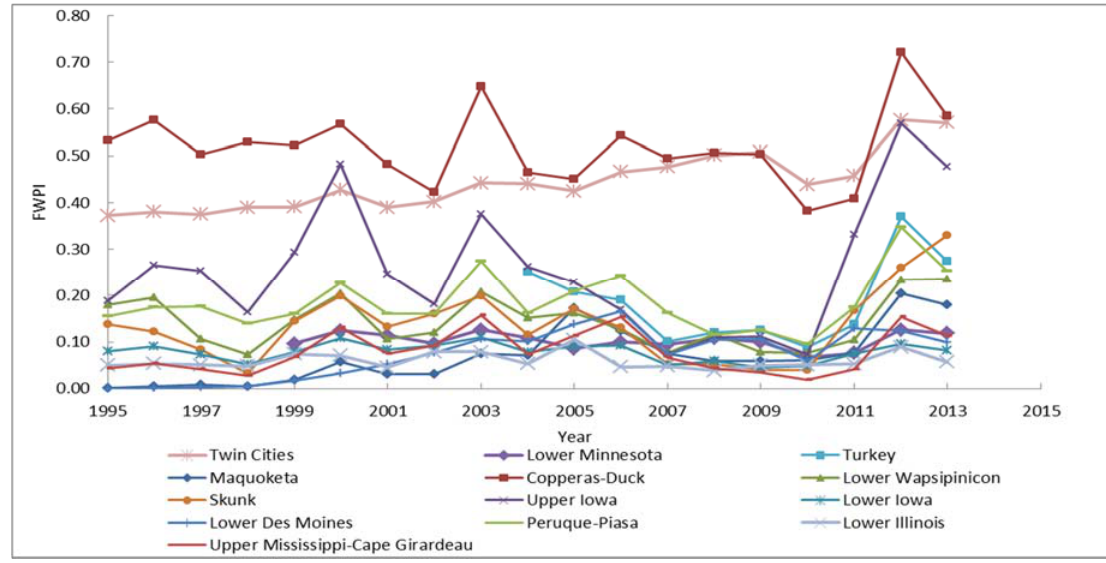
Figure 2. Freshwater Provision Index ( FWPI) from 1995 to 2013 for 13 watersheds in the UMRB.